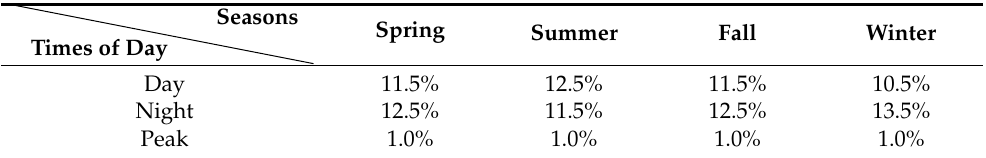
Table 3. Percentage subdivision of total time of the year among the time-slices (in TIMES-Italy and TEMOA-Italy) [58]. Seasons Spring Summer Fall Winter Times of Day Day 11.5% 12.5% 11.5% 10.5% Night 12.5% 11.5% 12.5% 13.5% Peak 1.0% 1.0% 1.0%